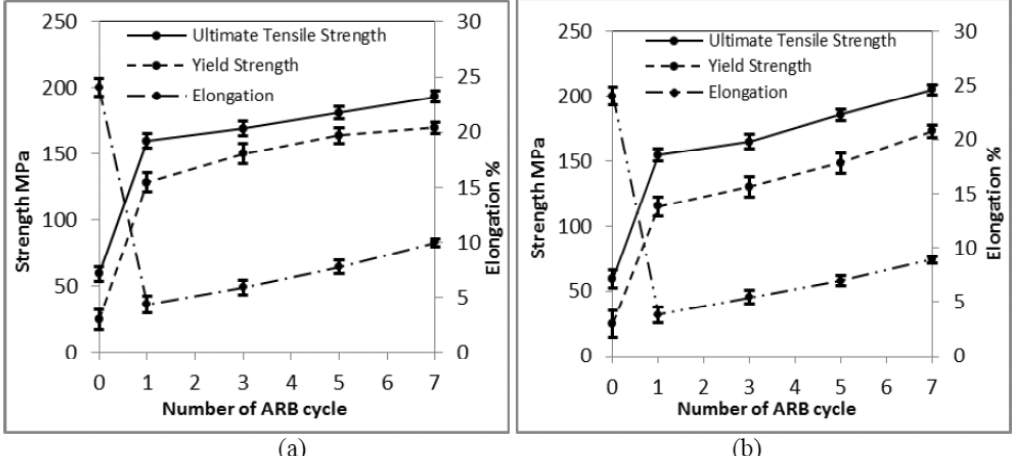
Fig. 8. The mechanical properties results of the Al-0.5wt.% TiO